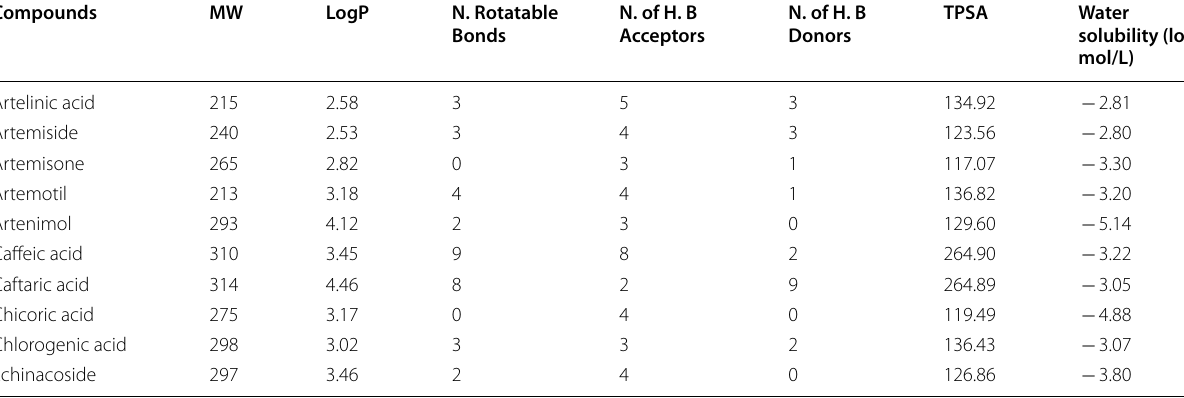
Table 4 Molecular properties descriptors of all studied compounds